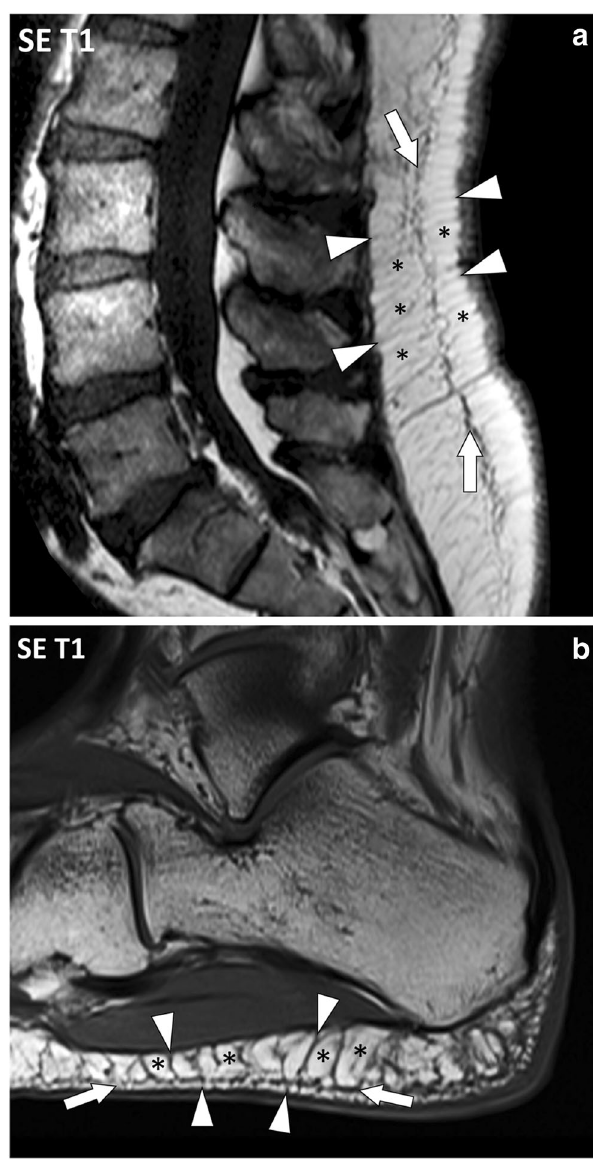
Fig.8 Sagittal SET1-weighted imagesof( a ) thelumbar spine and( b ) the heel of two different patients. The fascia superficialis (arrows) is well depicted with fibrous tracts (arrowheads) perpendicular to the dermis and to the deep peripheral fascia, delineating fat lobules (asterisks). These attachments vary according to the considered body segment